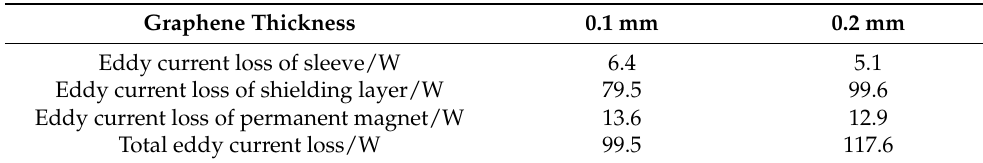
Table 4. The eddy current loss of the rotor corresponding to different thickness of the graphene shielding layer under load.